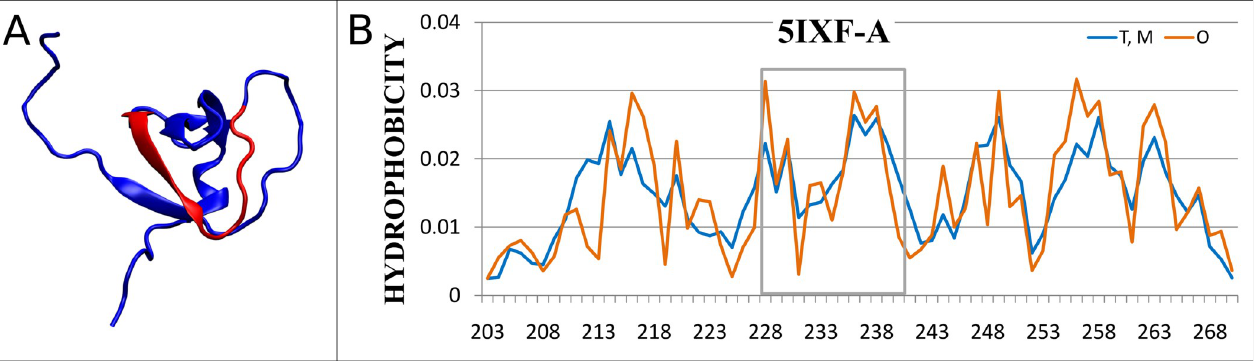
Fig 2. Characteristics of the 5IXF-A. A– 3D structure with highlighted IDR (in red). B– T and O hydrophobicity distributions (IDR marked by a box).